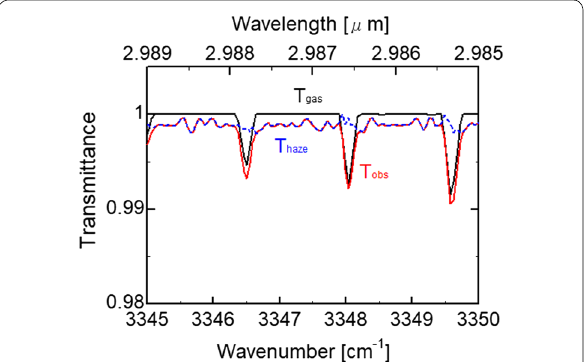
Fig. 4 Example of a calculated transmittance ( T gas , black spectrum), an observed transmittance ( T obs , red spectrum), and a residual transmittance ( T haze , dotted blue spectrum) measured at an altitude of 110.3 km corresponding to the observation obtained on Sep. 05, 2006 (order 149, orbit 137.1, latitude 79N ◦ , longitude 237 ◦ ). These wavelengths are selected to visualize the analysis